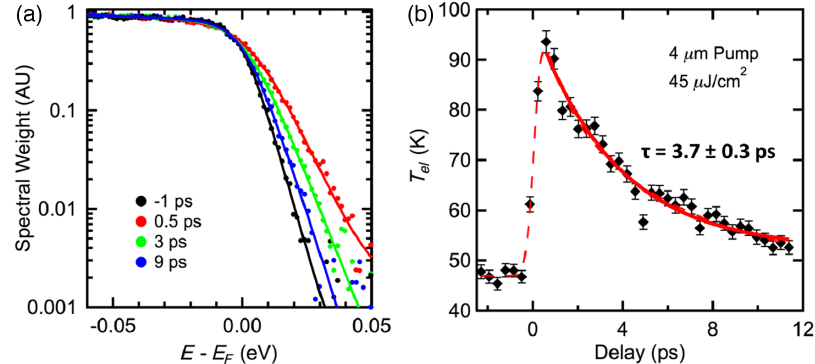
FIG. 3. Extracting electronic temperature from nodal Fermi edges. Panel (a) shows the k -integrated spectral weight for several delays along with Fermi-Dirac fits as solid lines (see Supplemental [39] for details). The momentum integration window is shown by the yellow line in Fig. 1(a). The electronic temperature T el is extracted from the Fermi fit (see Ref. [39]). This T el is plotted vs delay in panel (b) using a 4 - μ m fluence of 45 μ J = cm 2 , which brings the maximum T el to approximately T C . The temperature decay is fit to a single exponential, shown by the solid red line in panel (b), and the fit returns a decay time of 3 . 7 (cid:2) 0 . 3 ps. The dashed red line in panel (b) is a guide to the